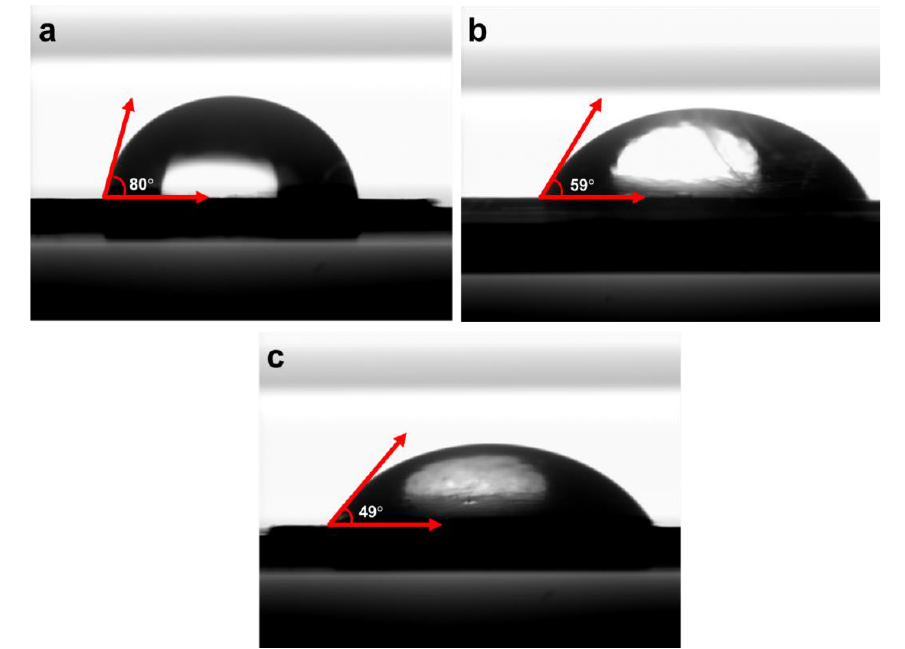
Figure 5. Contact angle measurement of ( a ) pristine PVDF, ( b ) nonwoven / PVDF-PAA and ( c ) nonwoven / PVDF-PAA / GO composite membranes.